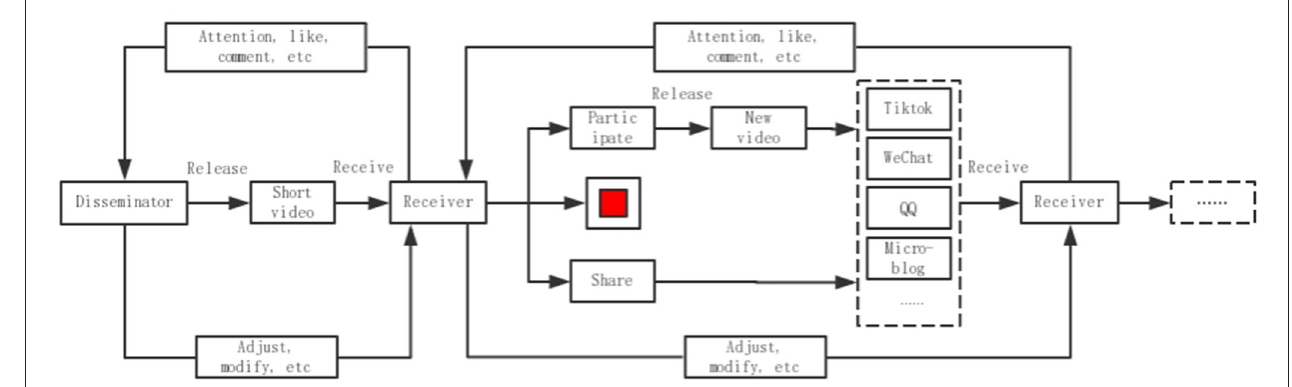
FIGURE 5 | Feedback roadmap of short fitness videos on